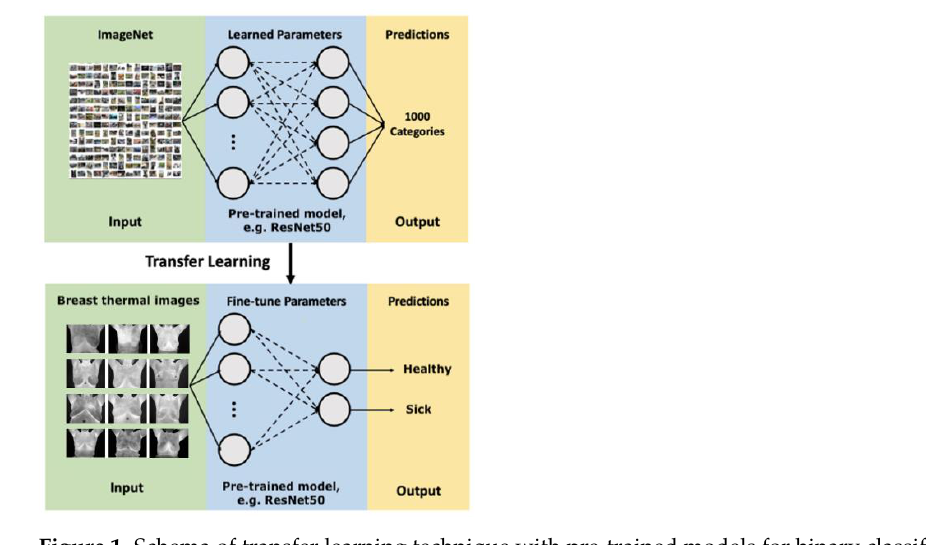
Figure 1. Schema of transfer learning technique with pre-trained models for binary classification.